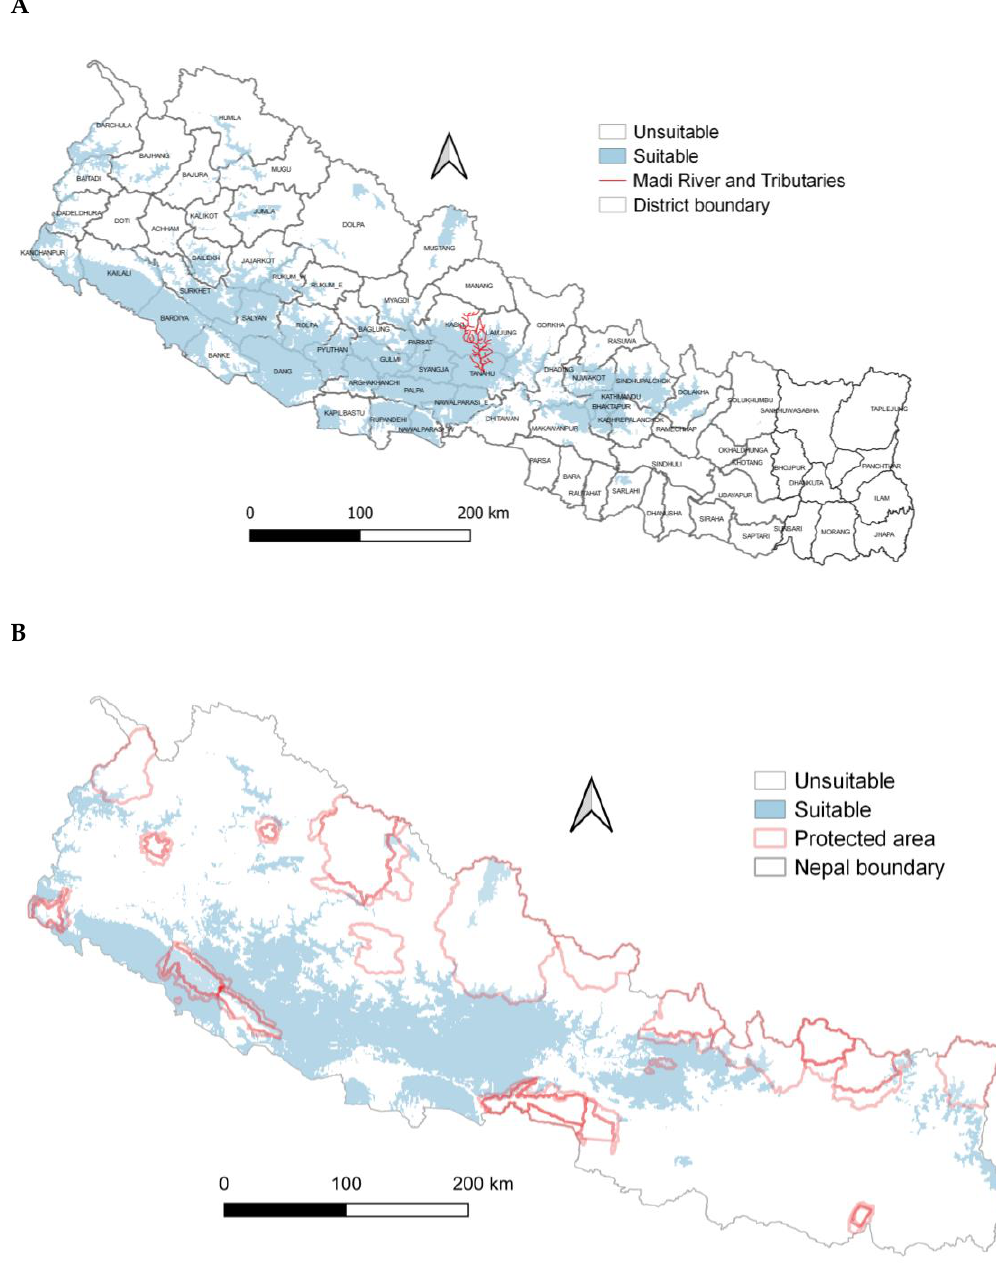
Figure 5. ( A ) Potential suitable nest habitat of Egyptian vultures, Nepal. ( B ) Potential suitable nest habitat of Egyptian vultures and protected areas,